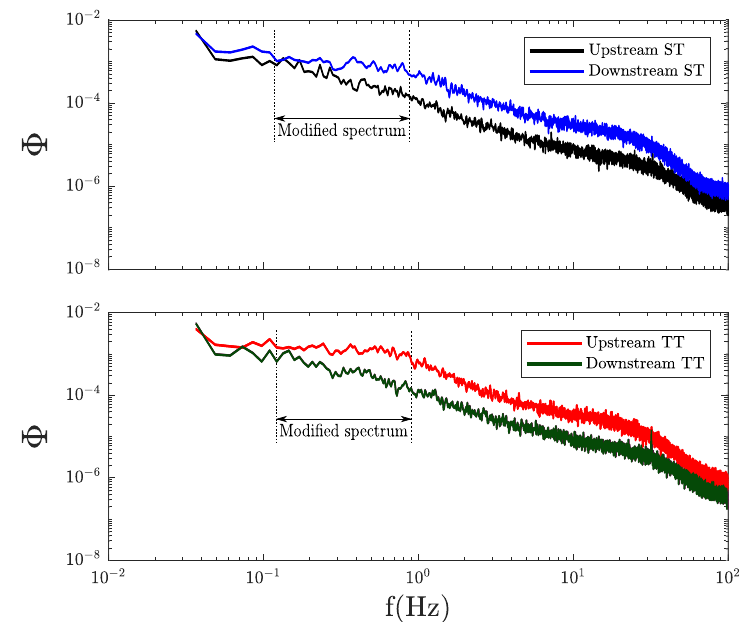
Figure 8. Velocity spectrum upstream and downstream of the primary turbine for the ST ( top ) and TT ( bottom ) cases. Surrounding flow effects are perceived in the same frequency range of the voltage